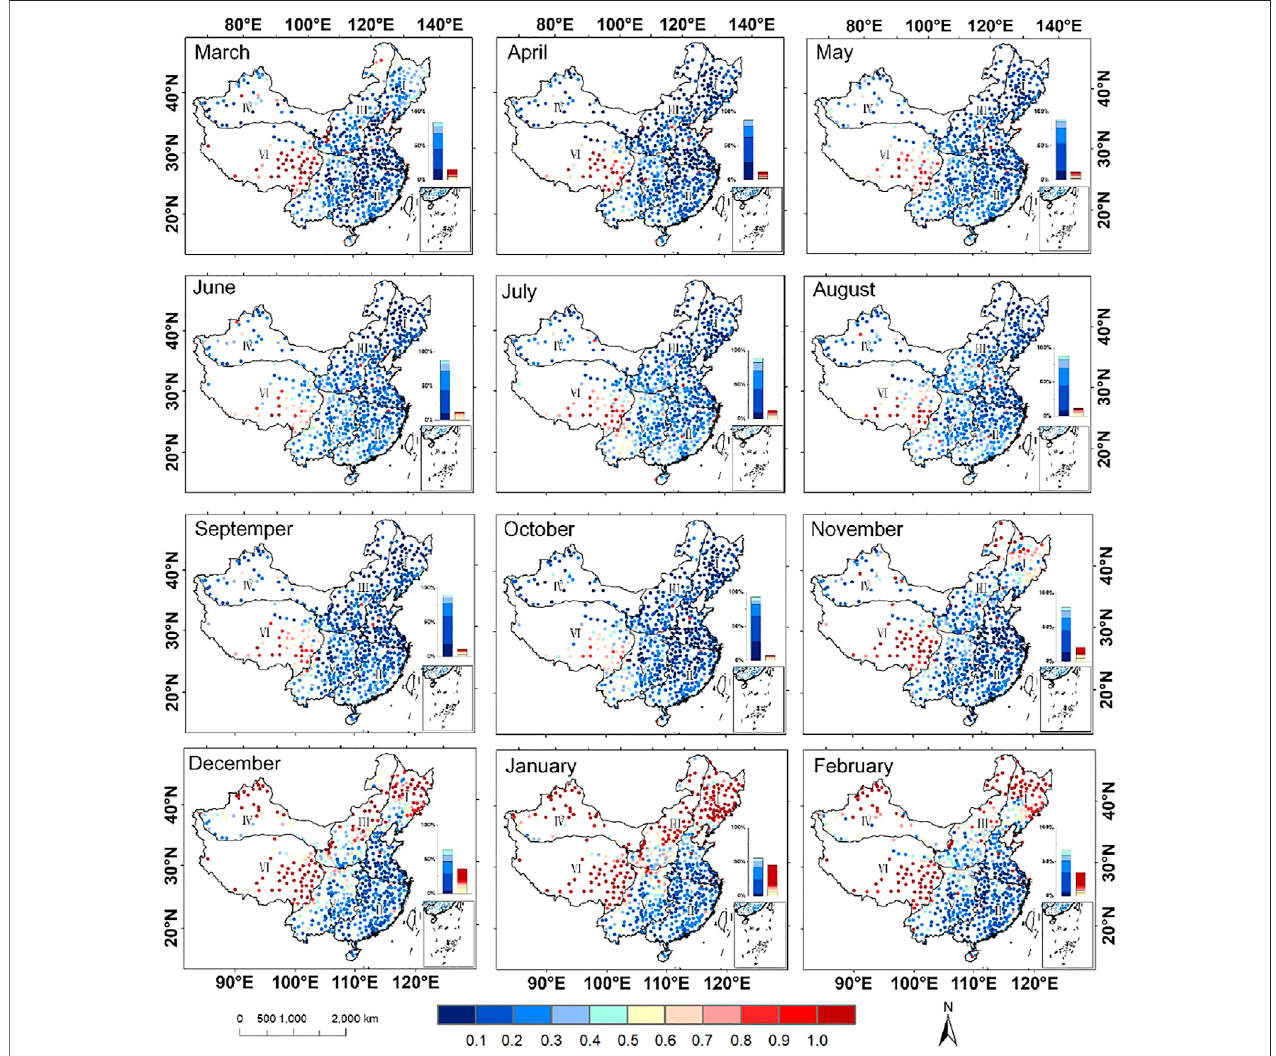
FIGURE 6 | Spatial distribution of DISO for TXx of the ERA5 over China from spring to winter. Spring (March, April, and May), summer (June, July, and August), autumn (September, October, and November), and winter (December, January, and February).